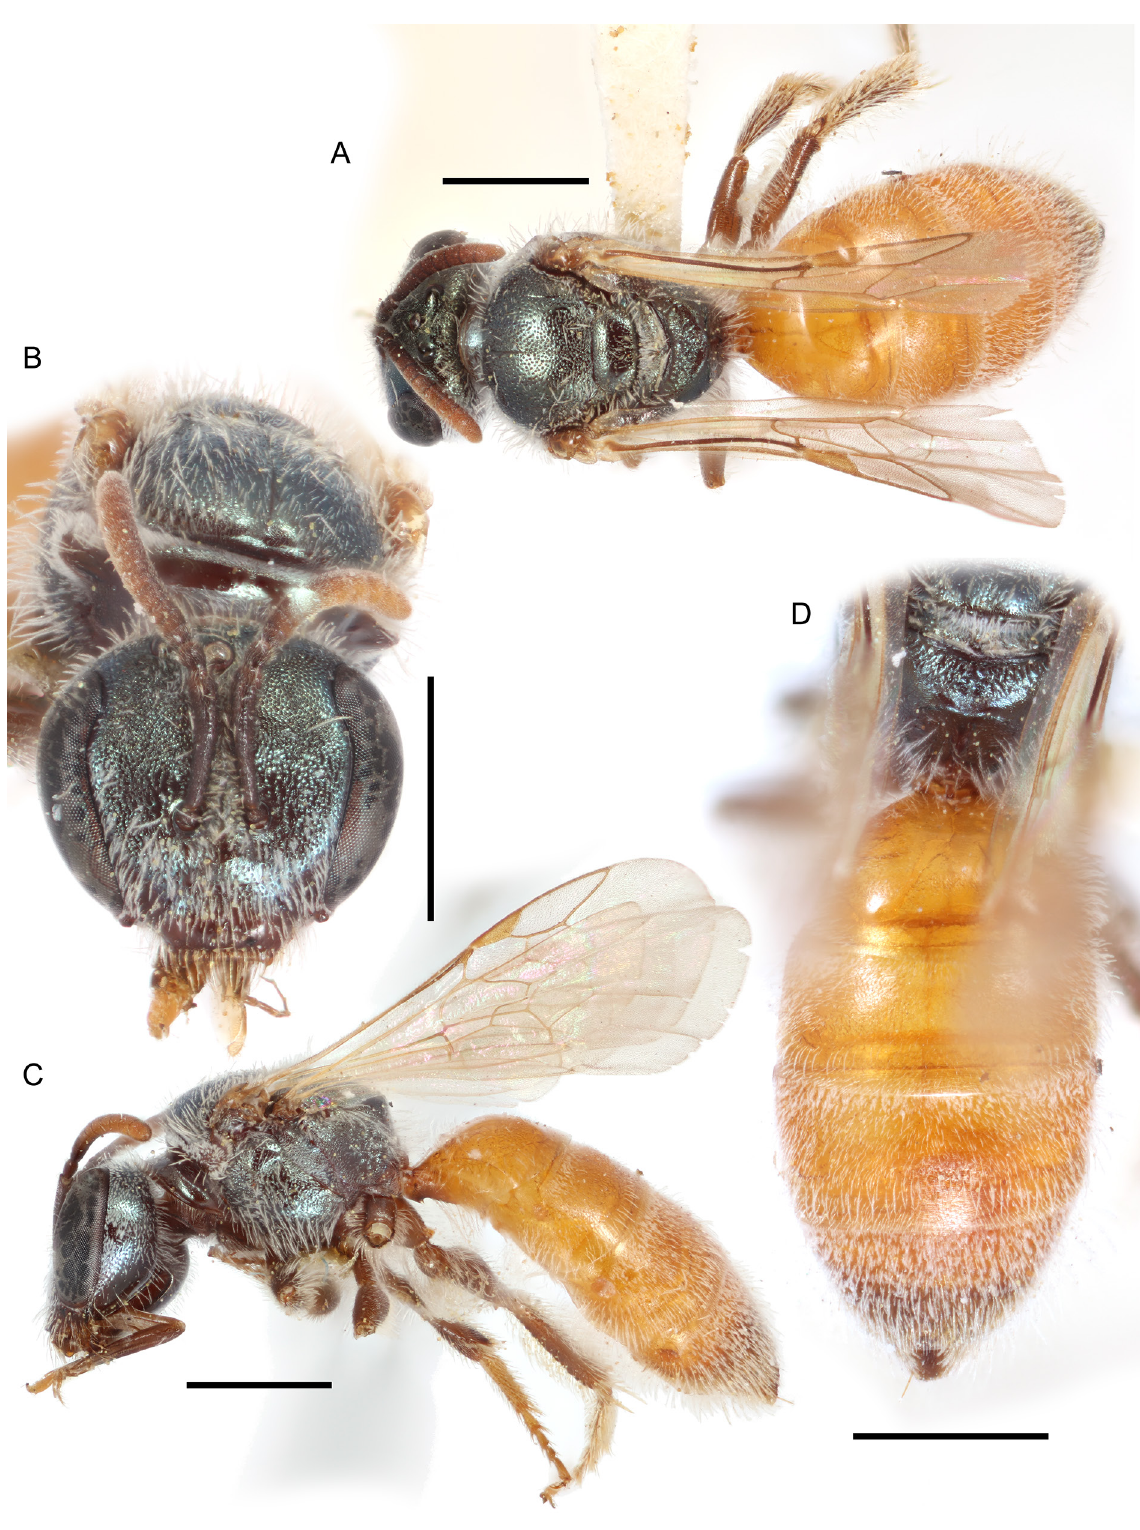
Fig. 43. Lasioglossum ( D. ) imbriumbrae sp. nov., ♀. A . Dorsal habitus. B . Face. C . Lateral habitus. D . Propodeum and metasoma. Scale bars: 1